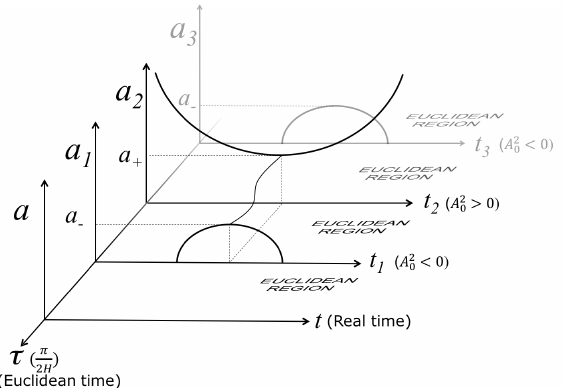
Figure 10. The universes of region III are cyclic universes that start from a big-bang singularity and end in a big-crunch one. In region I , the universe effectively behaves like a closed DeSitter